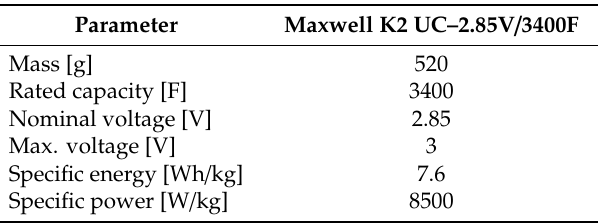
Table 2. Ultracapacitor cell features.